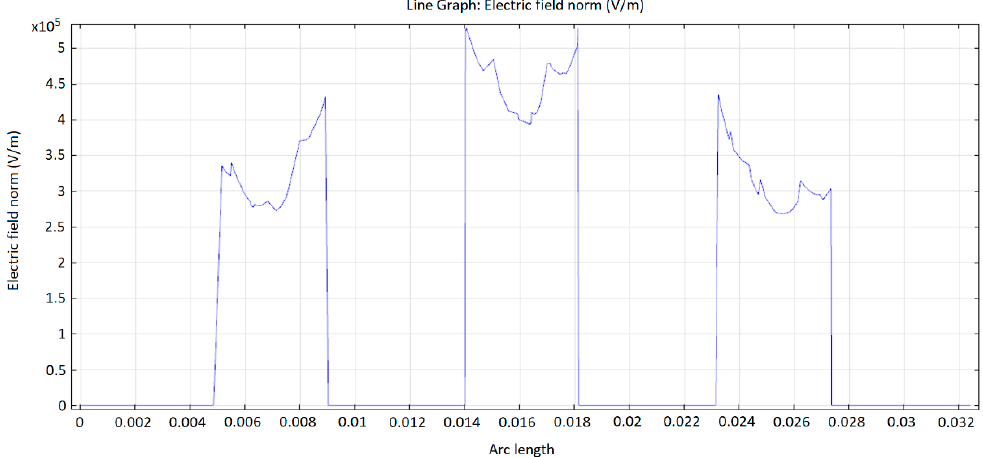
Figure 29. Results of the electric field distribution along the measurement lines for small lamellas.